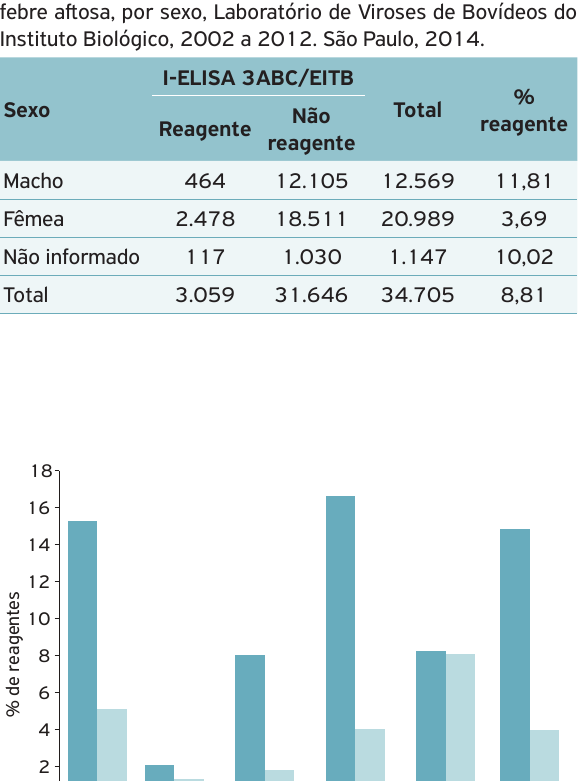
Tabela 3. Frequência de bovinos de propriedades rurais